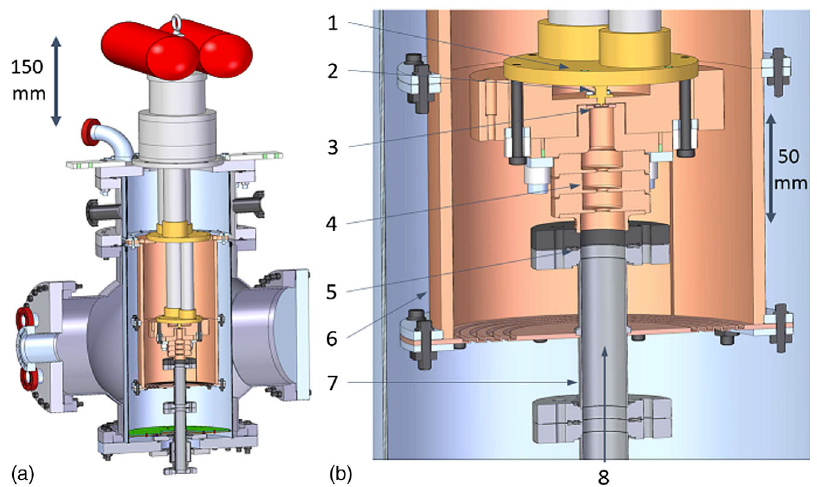
FIG. 3. (a) Solid model of the cryostat and (b) zoom in on Cryo-Cu-SLAC-#2 in same model. (1) Cold head of cryocooler; (2) current monitor; (3) brazed metal foil; (4) Cryo-Cu-SLAC-#2; (5) rf flange; (6) thermal shield; (7) Cu-plated stainless steel waveguide; (8) rf